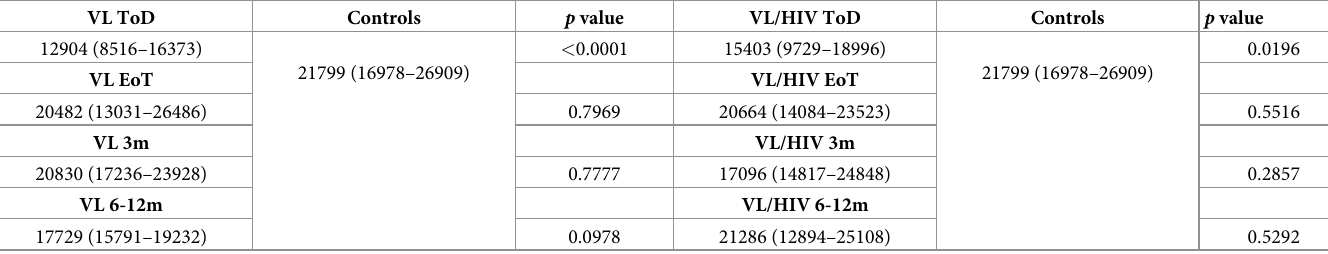
Table 4. Comparison of neutrophil Arginase 1 expression levels between VL and VL/HIV patients and controls over time. VL ToD